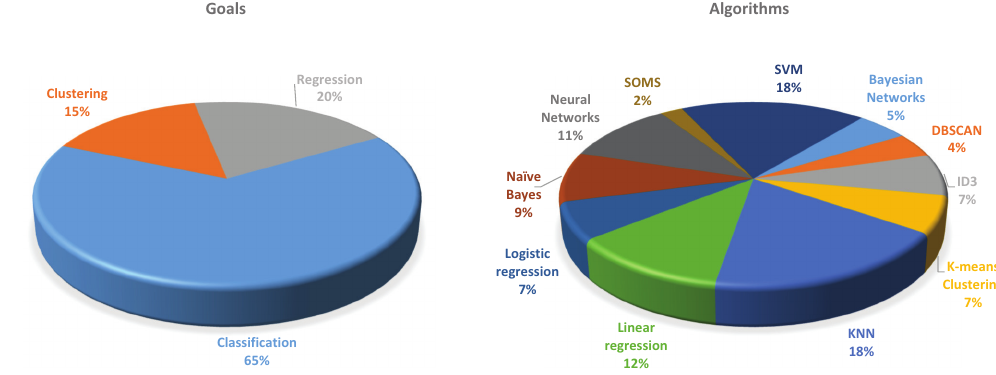
Figure 3. Number of references for each goal and algorithm.